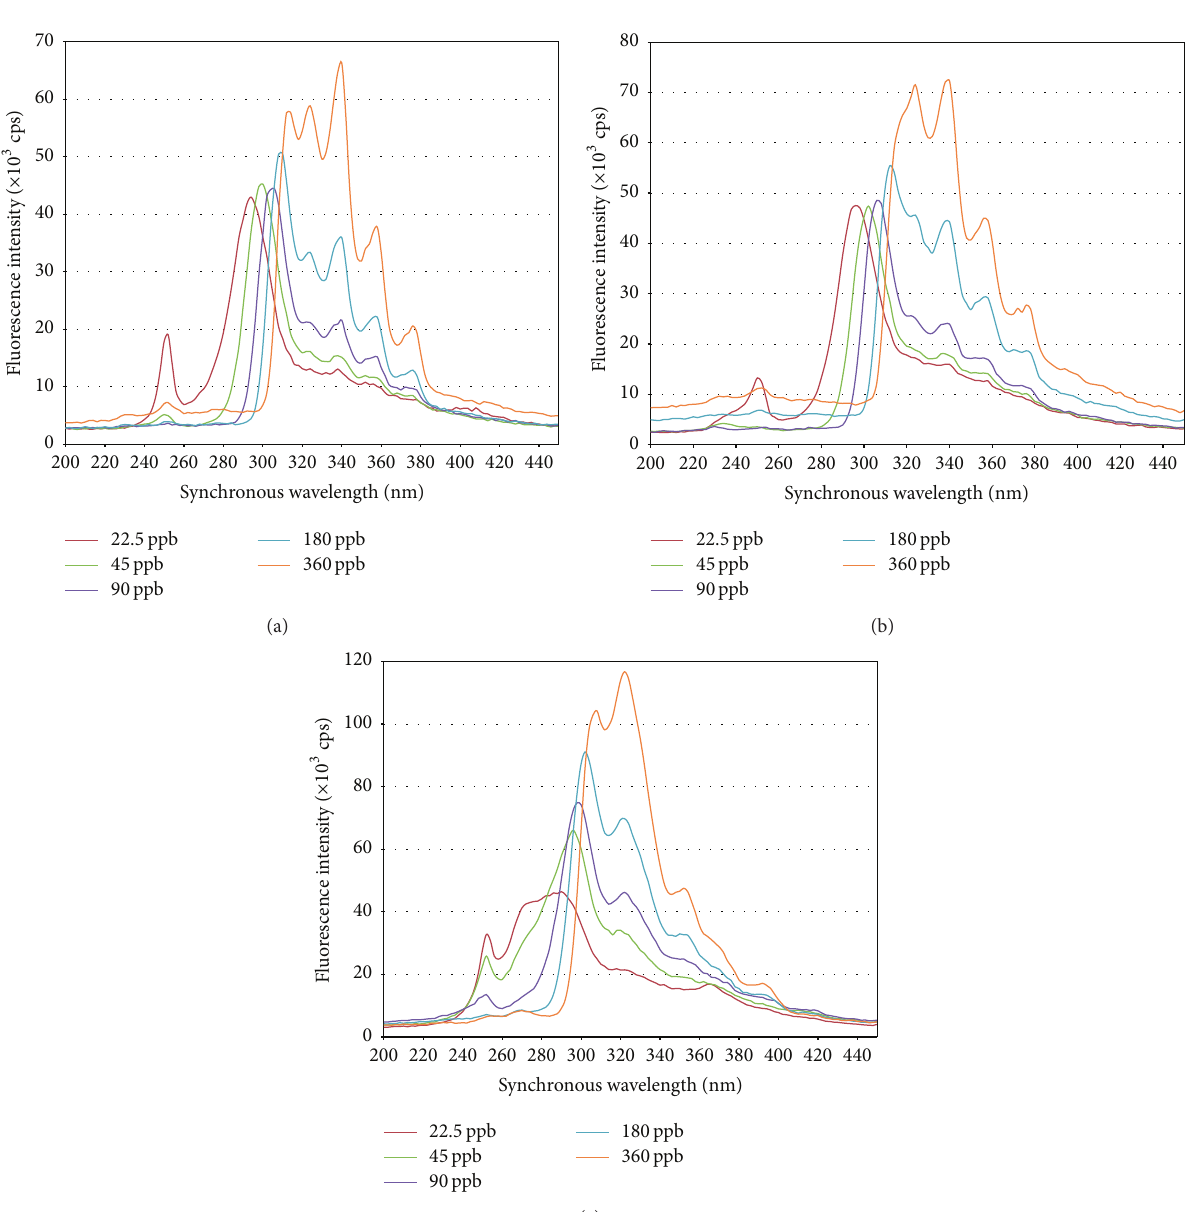
Figure 4: (a) Synchronous fluorescence spectra of various anthracene standard solutions at different concentrations prepared in the MSM- 0.5% medium. (b) Synchronous fluorescence spectra of various anthracene standard solutions at different concentrations prepared in the MSM-3% medium. (c) Synchronous fluorescence spectra of various anthracene standard solutions at different concentrations prepared in the MSM-10%